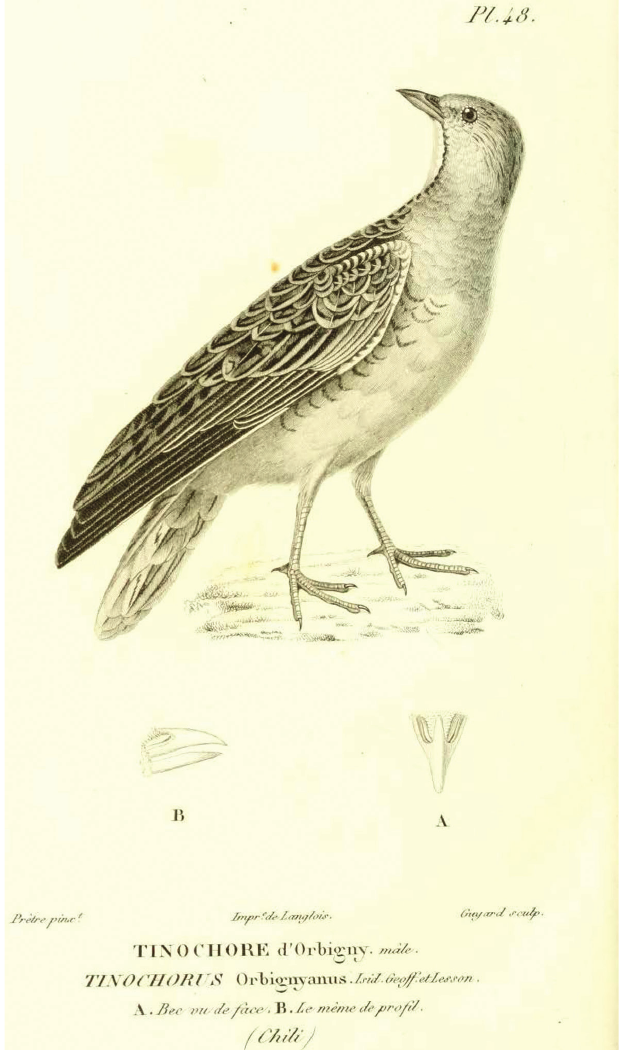
Figure 6: Thinocorus Orbignyianus (male), Lesson, Centurie zoologique , pl.